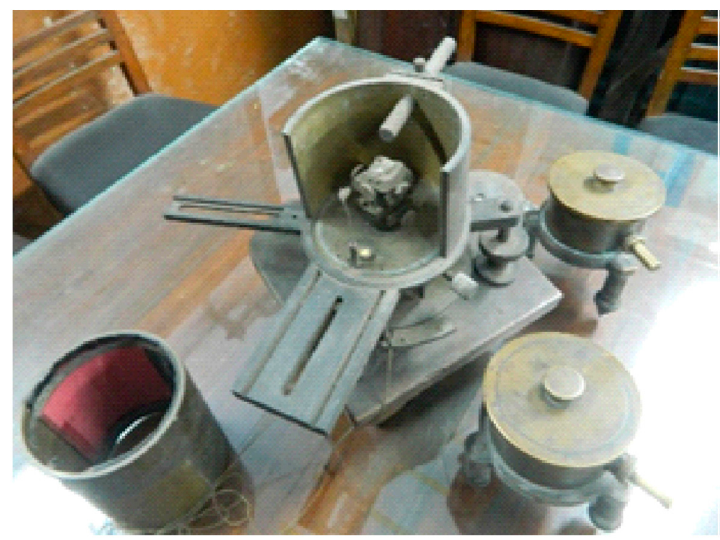
Figure 8. X-ray Diffraction Apparatus built by SN Bose. (Courtesy: Prof. Alok Mukherjee).